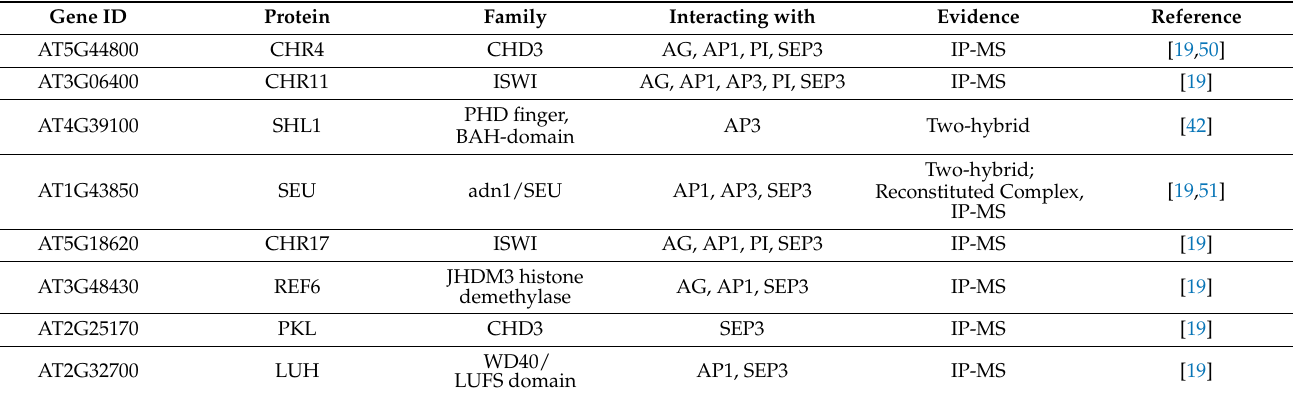
Table 2. Epigenetic regulators identified as interactors of floral organ identity factors.